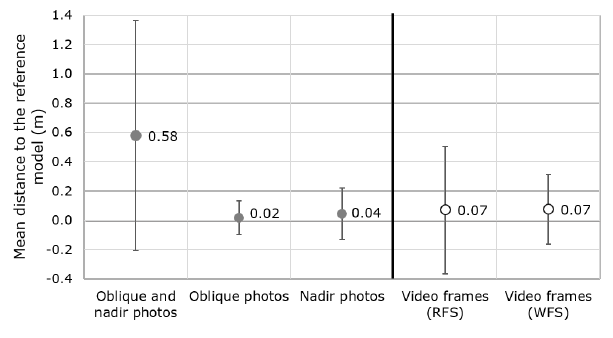
Figure 8. External accuracy assessment of video- and photo-based 3DPCs of Tainan. Comparison of the mean distance between the analyzed and the reference 3-D point